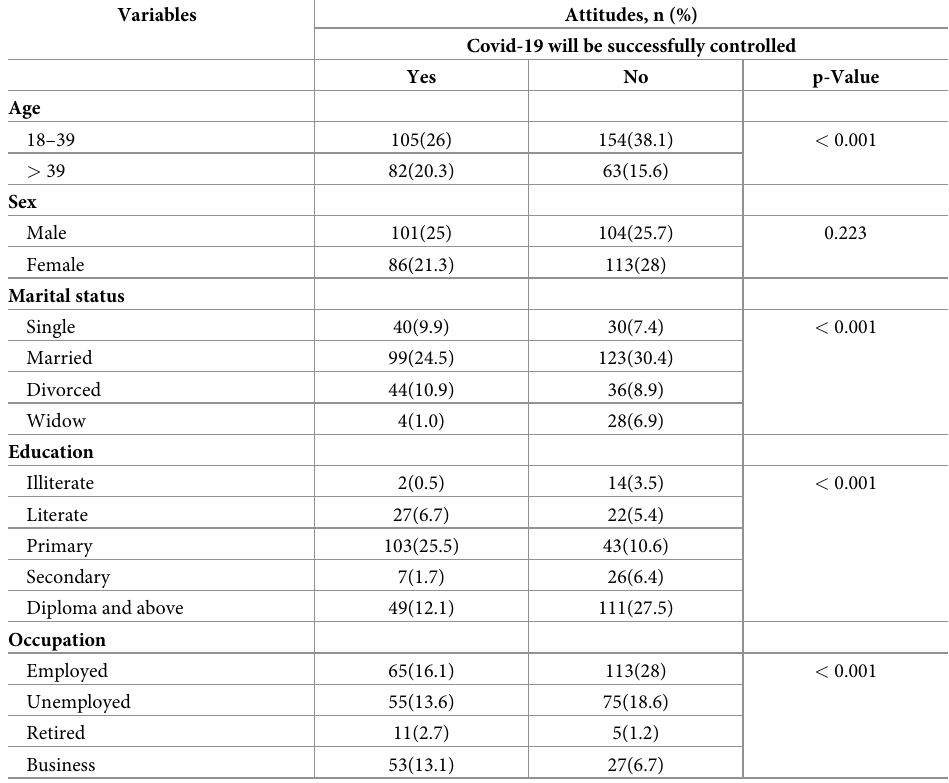
cleaning their working place surface [Table 6]. The practices of the respondents towards COVID-19 were statistically (p < 0.01) associated with sex, marital status, education and occu- pation [Table 7]. Table 5. Bivariate analysis to determine the association of attitude with socio-demographic characteristics of the respondents towards COVID-19 (n = 404). Variables Attitudes, n (%) Covid-19 will be successfully controlled Yes